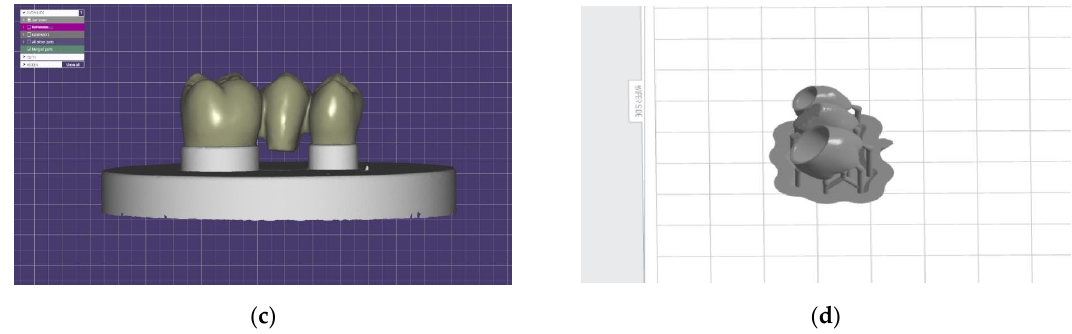
Figure 2. Design procedure for 3-unit restoration specimen. ( a ) Optical image of metal jig was acquired using a desktop scanner after scan powder was applied; ( b ) CAD parameters for fixed dental prosthesis were set in virtual model of the metal jig; ( c ) lateral view of completed design; ( d ) design data were loaded on pre-processing slicing software. Materials 2020 , 13 , x FOR PEER REVIEW